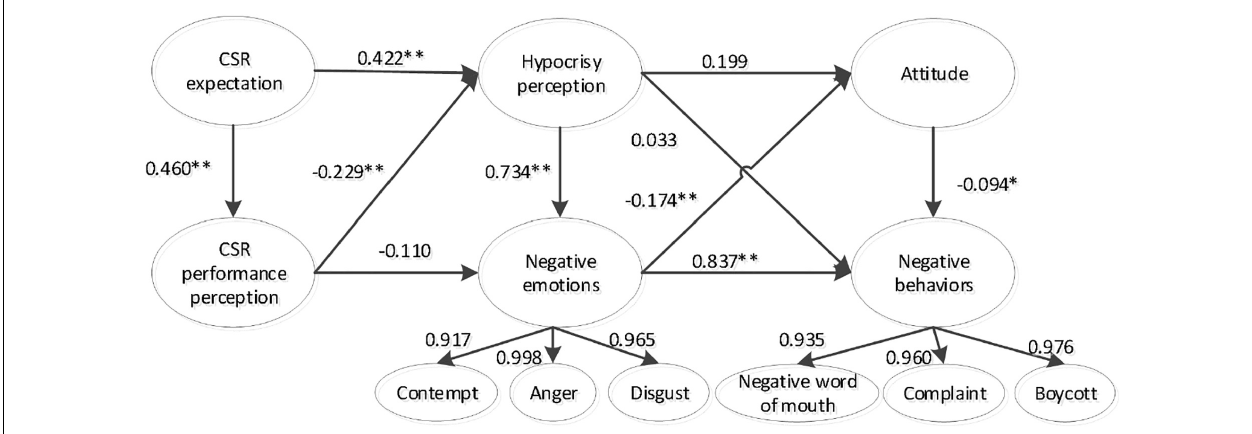
FIGURE 2 | Path analysis of the structural equation model. Note. * p < 0.05, ** p < 0.01.